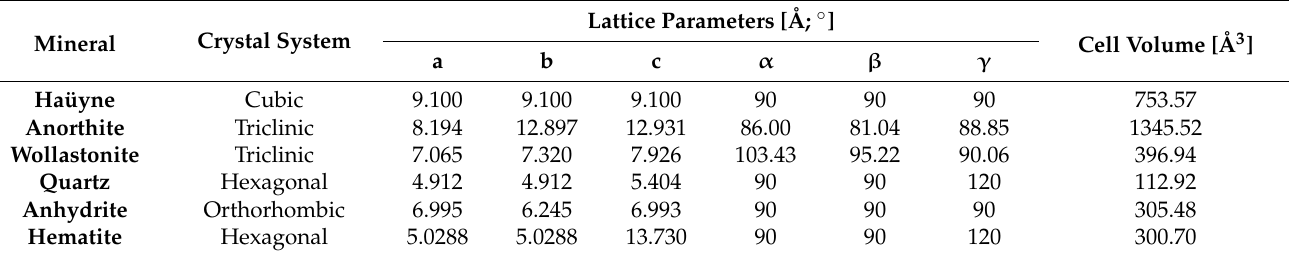
Table 6. Crystallographic parameters of identified minerals in test samples.